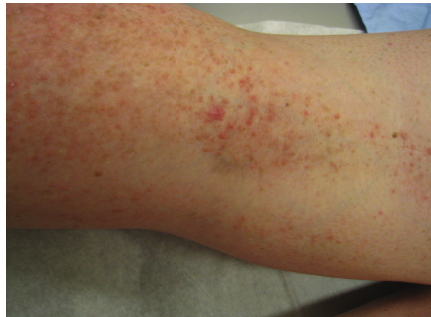
Figure 4: Left popliteal fossa demonstrating a shiny telangiectatic papule within a linear collection of keratotic papules in the left popliteal